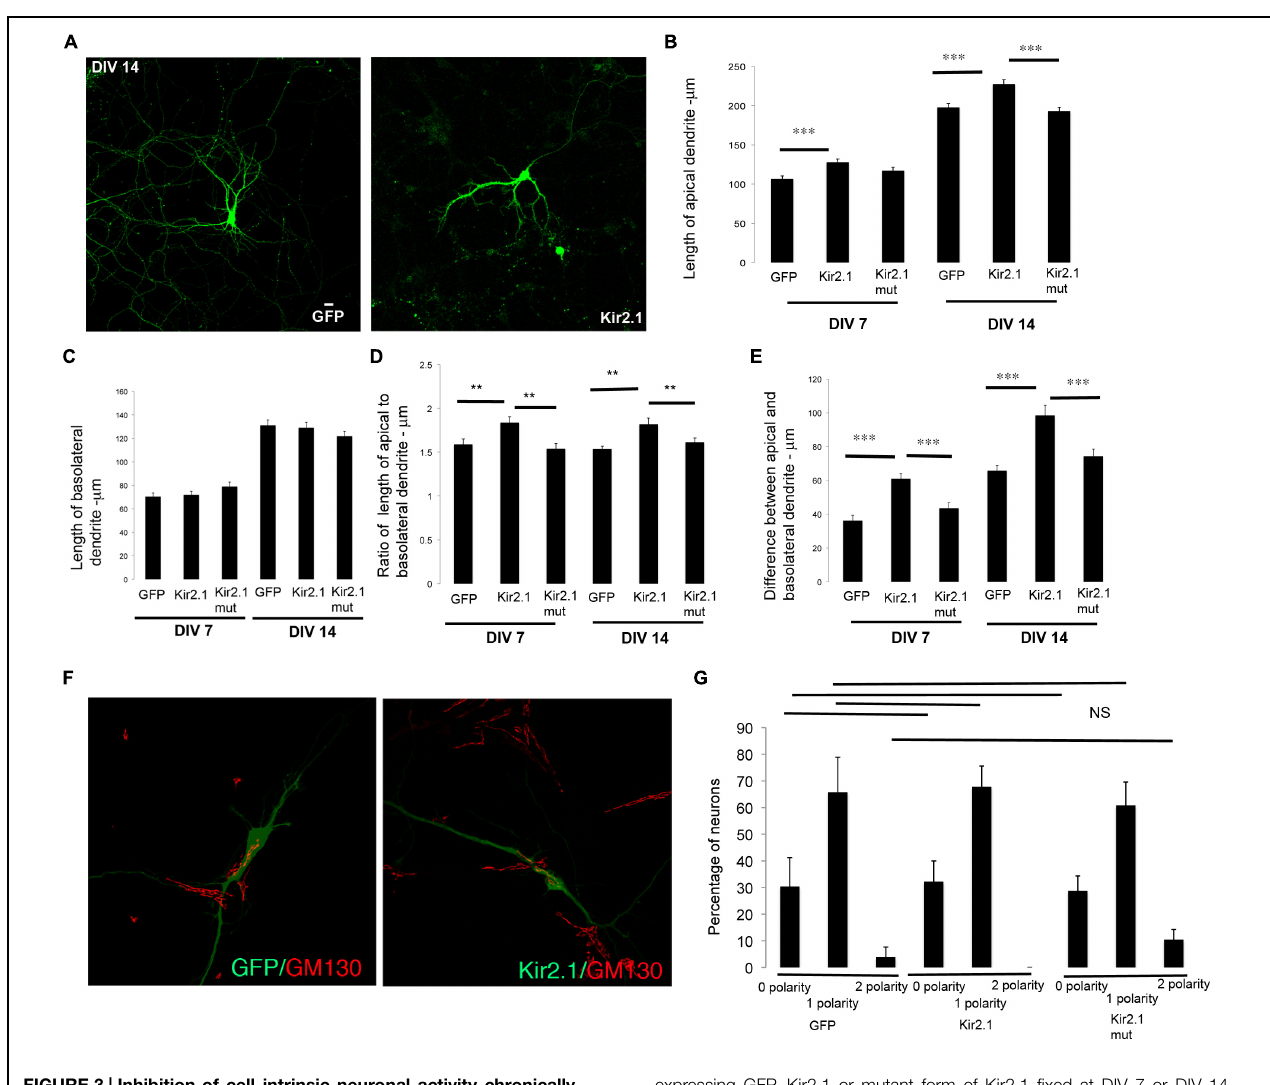
expressing GFP, Kir2.1 or mutant form of Kir2.1 fixed at DIV 7 or DIV 14. (F) Confocal images of neurons expressing GFP or GFP and Kir2.1 and immunostained with anti-GM130. (G) Percentage of neurons with Golgi polarized toward 0, 1, or 2 dendrites in neurons expressing GFP or Kir2.1 or mutant form of Kir2.1, fixed at DIV 7. (Error bars represent SEM, One way Anova, P < 0.005 - ∗∗ , P < 0.0005 - ∗∗∗ , scale bar – 20